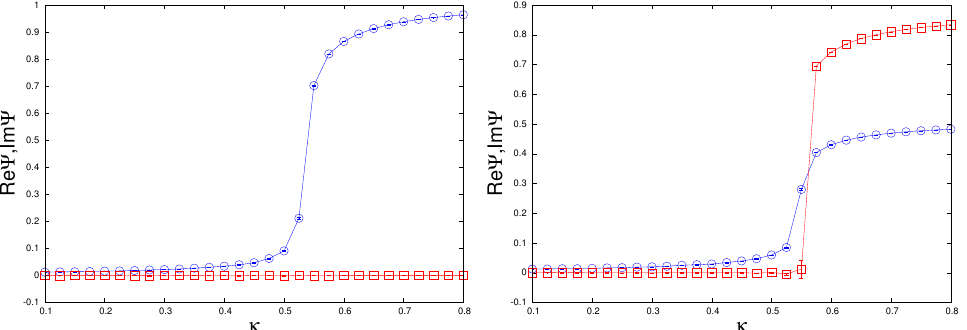
Figure 2. The κ -dependence of Ψ . The ( left ) and ( right ) panels show the results at θ = 0 and π /3 − (cid:101) , respectively. The circle and square symbols are the results of the real and imaginary parts of Ψ , respectively.